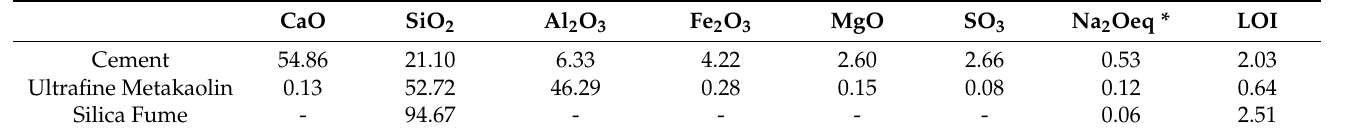
Table 1. Main chemical compositions of raw materials/%.